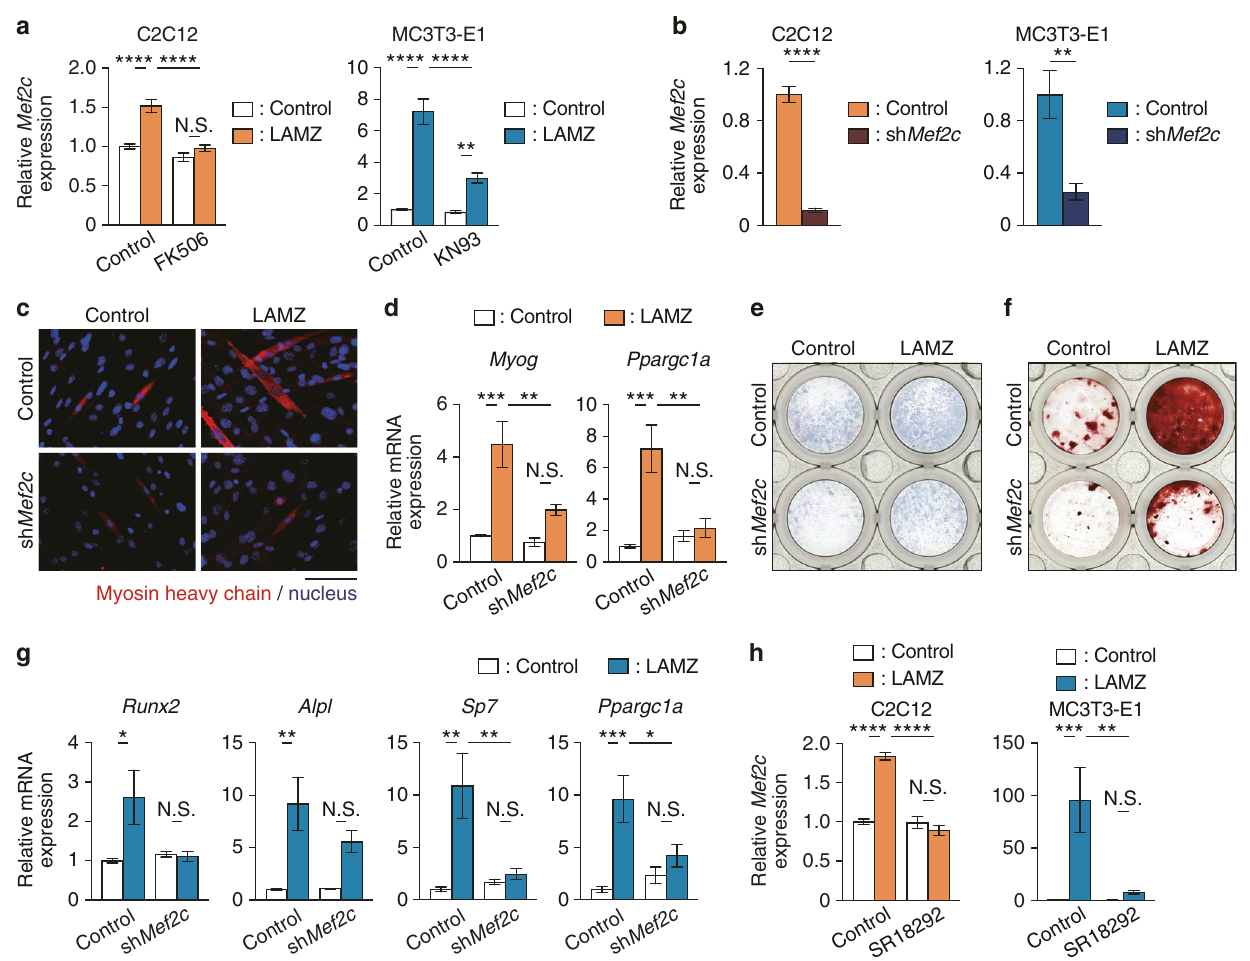
Fig. 5 LAMZ induces Mef2c to enhance myogenesis and osteoblastogenesis. a mRNA expression of Mef2c in the C2C12 cells and MC3T3-E1 cells treated with calcium signal inhibitors together with LAMZ. b mRNA expression of Mef2c in the C2C12 cells and MC3T3-E1 cells infected with lentiviruses encoding sh Mef2c . c Representative immunocyto fl uorescence images of the C2C12 cells infected with lentiviruses encoding sh Mef2c and treated with LAMZ. Myosin heavy chain (red); nuclei (blue). Scale bar, 100 μ m. d mRNA expression of Myog and Ppargc1a . e Representative ALP staining images of the MC3T3-E1 cells infected with lentiviruses encoding sh Mef2c and treated with LAMZ. f Representative images of Alizarin Red S staining of MC3T3-E1 cells. g mRNA expression of osteoblastic genes and Ppargc1a . h mRNA expression of Mef2c in the C2C12 cells and MC3T3-E1 cells treated with the PGC-1 α inhibitor SR18292. Experiments were repeated 3 times with replicates of two wells. For the comparison of two groups, statistical analyses were carried out using Welch ’ s t test. For multiple comparisons, two – way ANOVA and Tukey ’ s multiple-comparison test were applied. The error bars show the mean ± s.e.m. * P < 0.05; ** P < 0.01; *** P < 0.001; **** P < 0.000 1; N.S. not signi fi